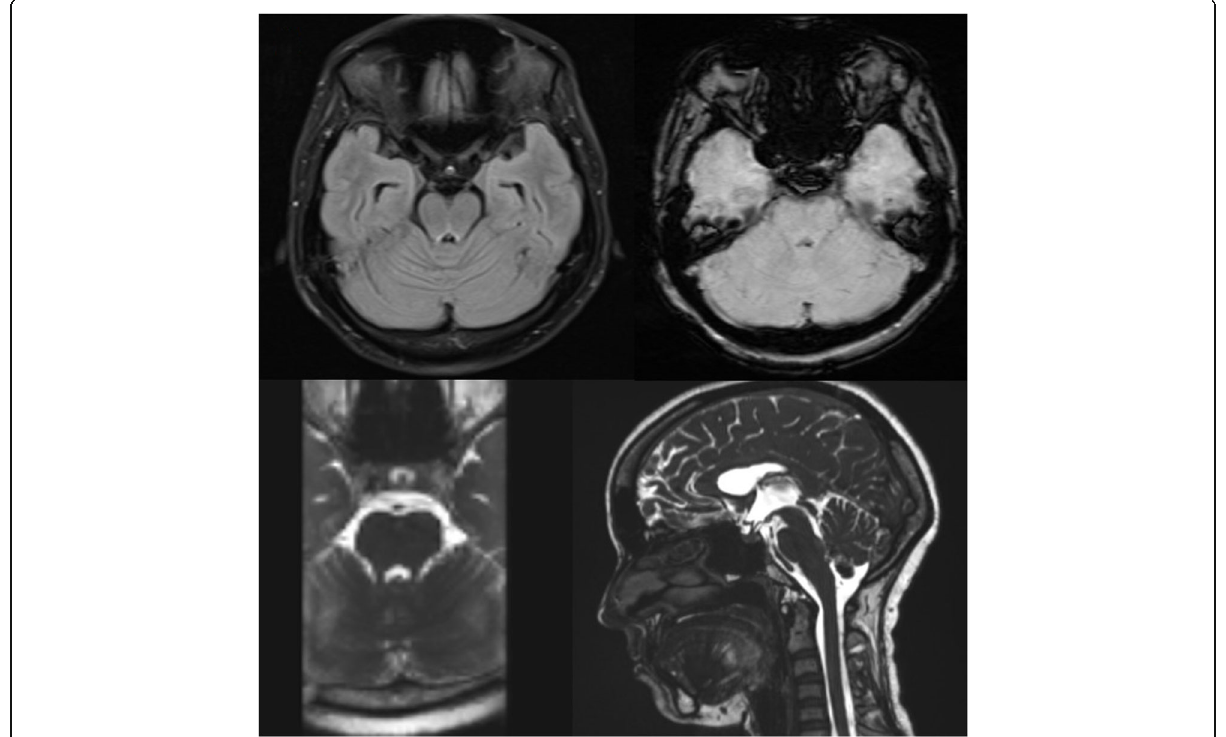
Fig. 3 Post neuroendoscopy neuroimaging showing normal fourth ventricle with no evidence of